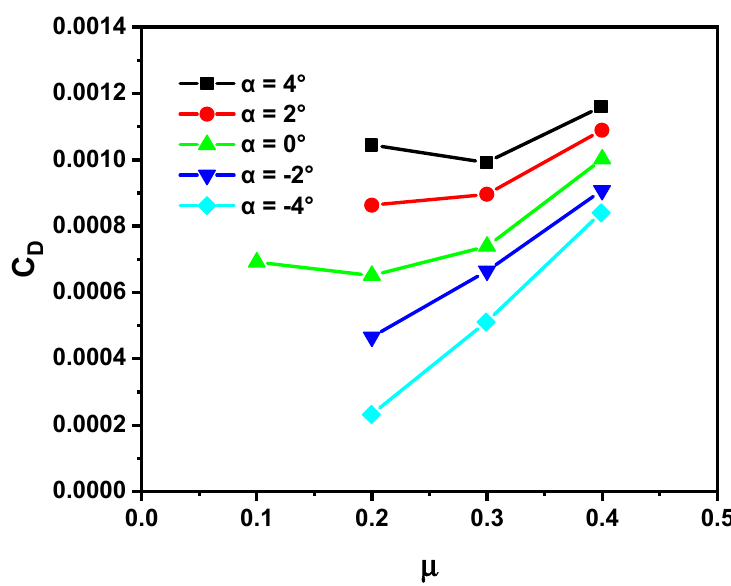
Figure 10. Drag force coefficient (C D ) as a function of the advance ratio ( μ ), 1860 rpm.